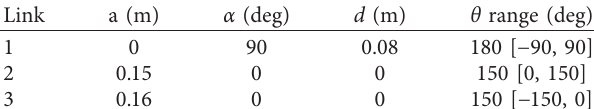
Table 2: D-H parameters of the